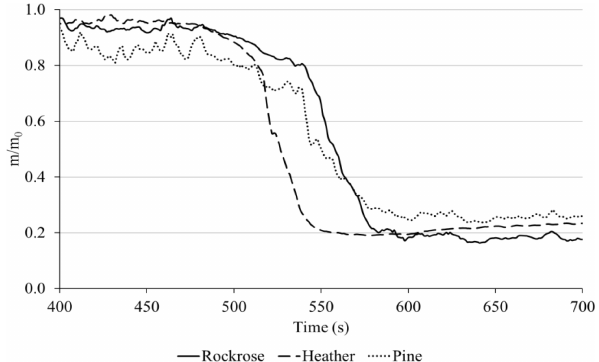
Figure 9. Average heat flux measurement according to the distance from the fire